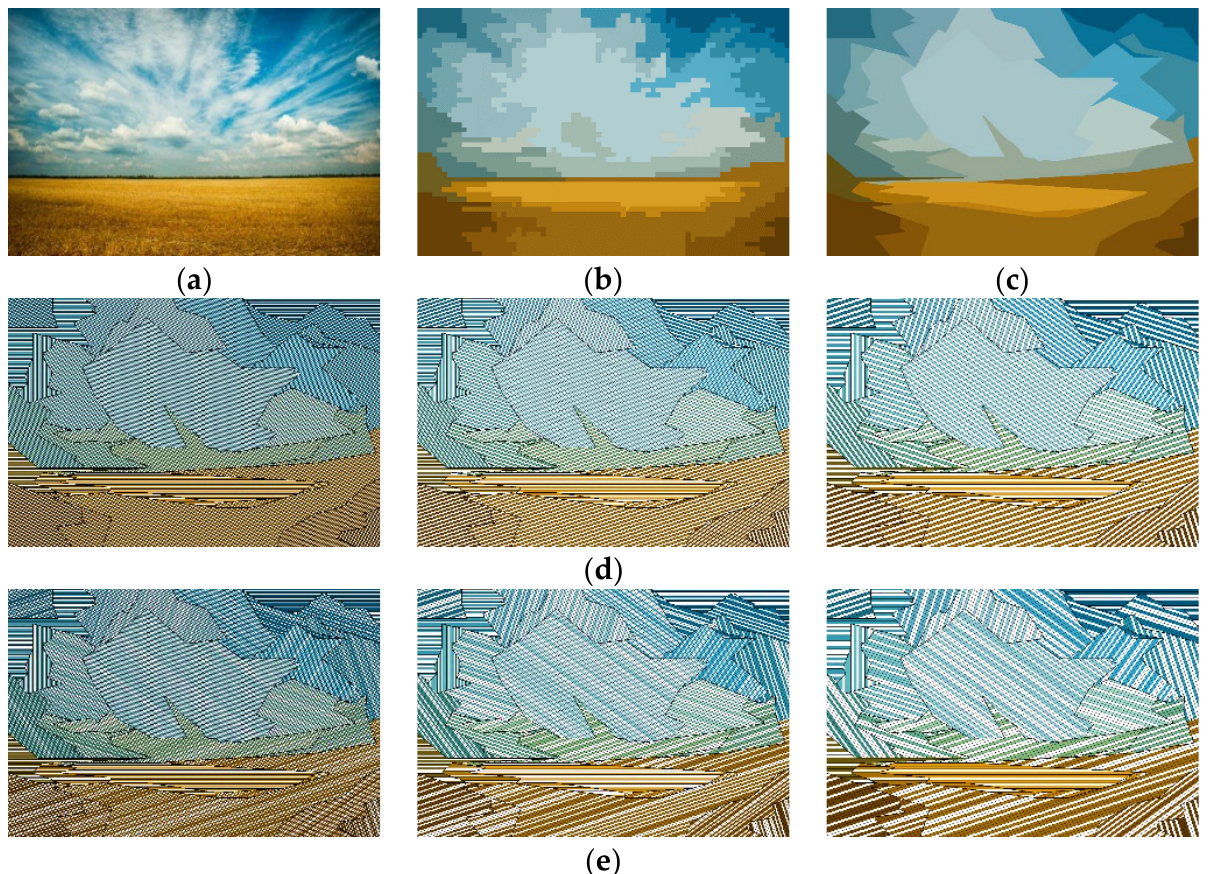
Figure 16. Experimental result 4. ( a ) An original image by Oleksandr Pidvalnyi [31]. ( b ) The result of image segmentation of ( a ). ( c ) The result of polygon approximation of ( b ). ( d ) Three Futurism-like images created from ( a ) with the stripe widths of 3, 6, and 9 pixels, respectively. ( e ) Three stego-images created from ( a ) by embedding the message “Make hay while the sun shines.” with the secret key “Positive” and the stripe widths of 3, 6, and 9 pixels, respectively.